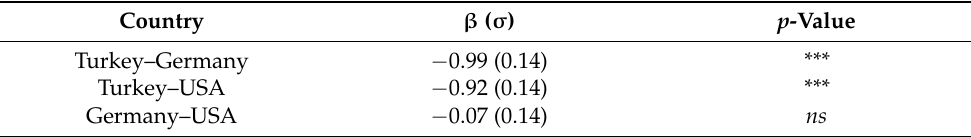
Table 4. Post hoc Tukey test for the three levels of the Country variable. Country β ( σ ) p -Value Turkey–Germany − 0.99 (0.14) *** Turkey–USA − 0.92 (0.14) *** Germany–USA − 0.07 (0.14)